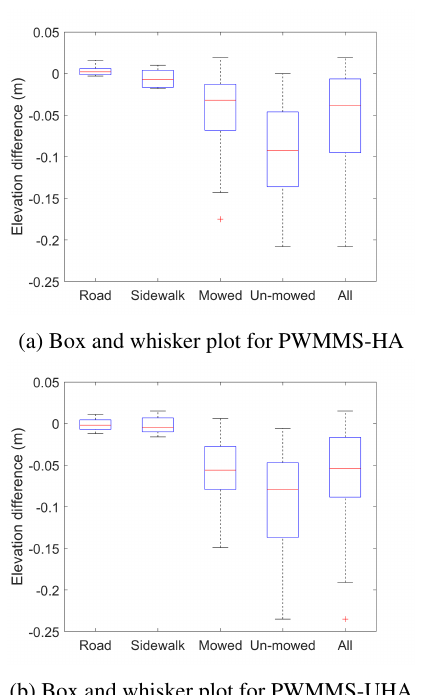
Figure 4: Cross-sectional profile of the ditch at location iii.